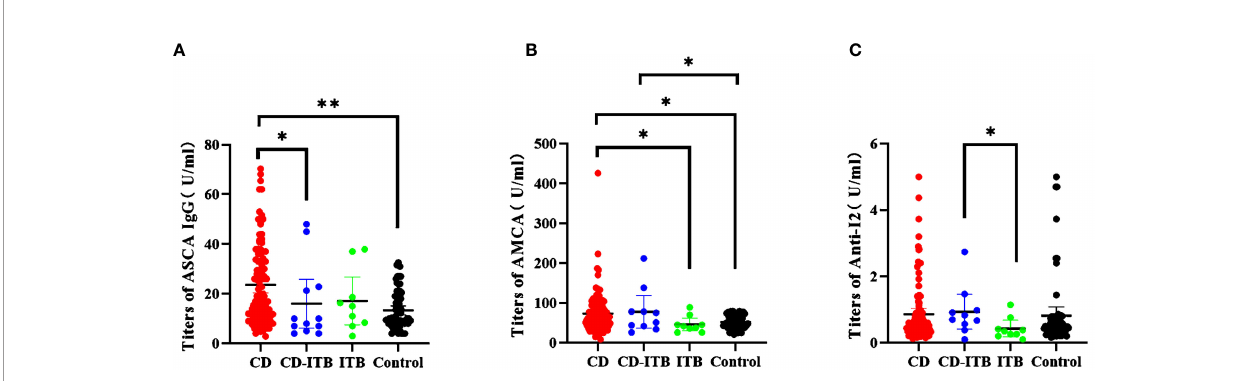
FIGURE 4 | Distinguishing CD combined ITB patients from ITB patients, CD patients and healthy controls. (A) The titers of ASCA IgG (CD vs CD-ITB P = 0.0351; CD vs Control P < 0.0001; (B) The titers of AMCA (CD vs ITB, P = 0.0341; CD vs Control, P = 0.00222; CD-ITB vs ITB, P = 0.071;CD-ITB vs Control P = 0.0022); (C) The titers of Anti-I2 (CD-ITB vs ITB, P = 0.044; CD-ITB vs Control, P = 0.0553) *P < 0.05, **P